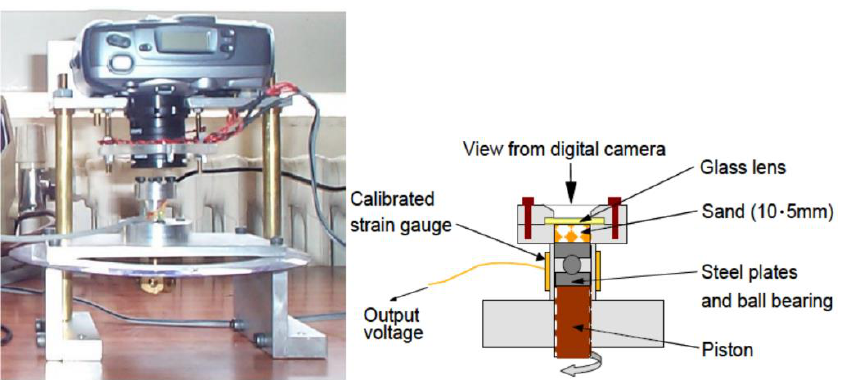
Figure 16. Set-up of miniature odometer for capturing images of microstructure during 1D com- pression (based on Figure 4 from [119]; reproduced by 2021 permission of Taylor & Francis